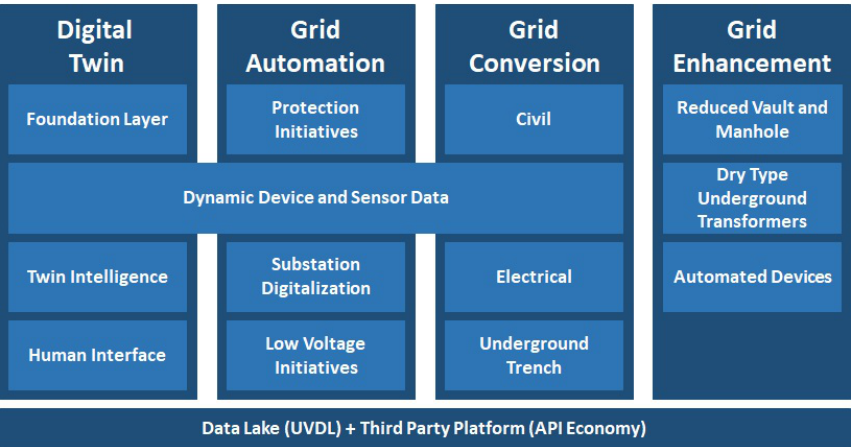
Figure 3. NDT© layers developed during the UF